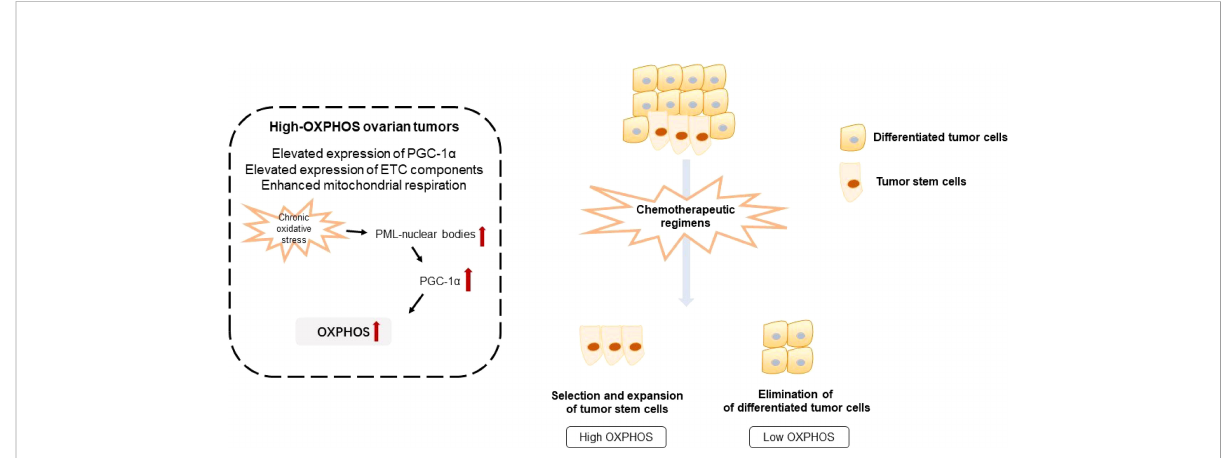
FIGURE 2 Illustration of oxidative phosphorylation and chemotherapeutic resistance of ovarian tumors. OXPHOS, oxidative phosphorylation; ETC, electron transport